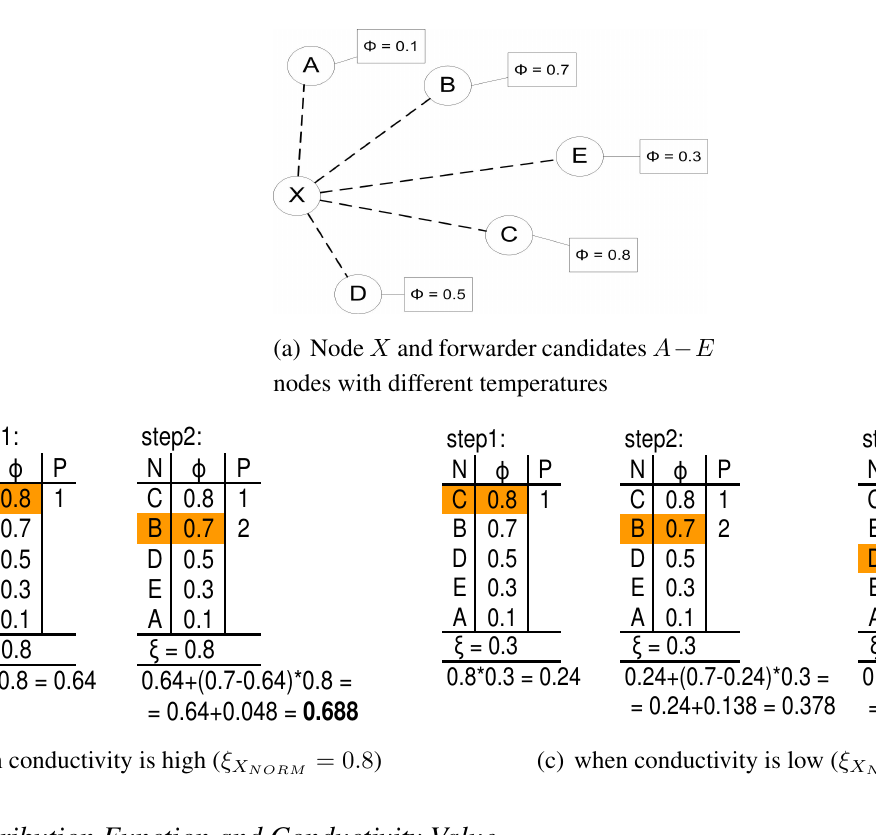
Figure 2. Heat computation algorithm (N-neighbor, φ -temperature,